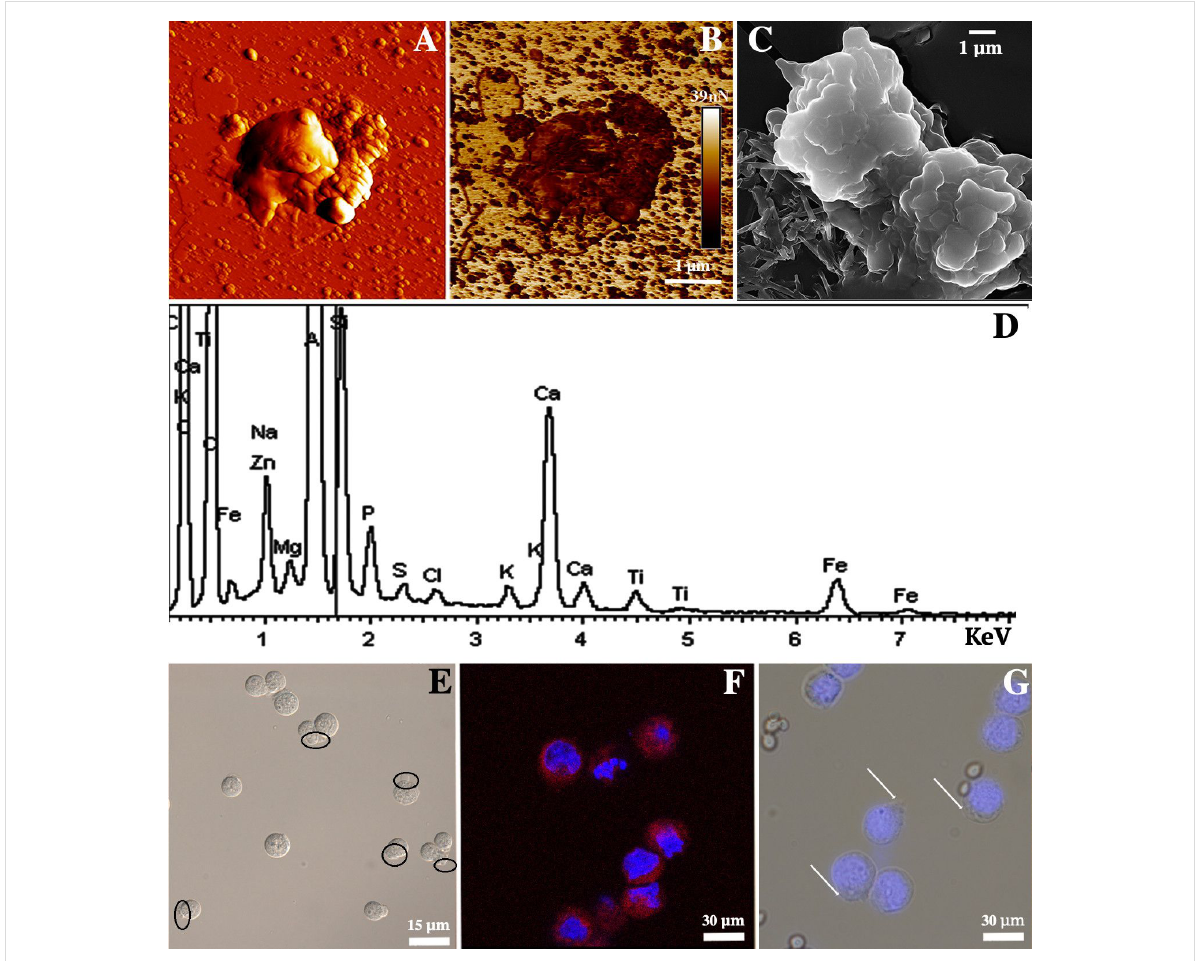
Figure 4: Atomic force microscopy (PeakForce Tapping mode) images of inorganic silica/halloysite imprints templated on HeLa cells: (A) topography image, (B) non-specific adhesion map; (C) scanning electron microscopy image of inorganic silica/halloysite imprints templated on HeLa cells; (D) EDX spectrum taken from the sample shown in (C), demonstrating the typical silica and halloysite elemental distribution; (E) optical and (F) confocal microscopy images demonstrating the recognition of HeLa cells with cell-templated imprints (cell nuclei stained with DAPI, imprints with rhodamine B in panel (F); (G) optical microscopy image of selective recognition of HeLa cells by the imprint in a mixture of human cells with yeast cells.